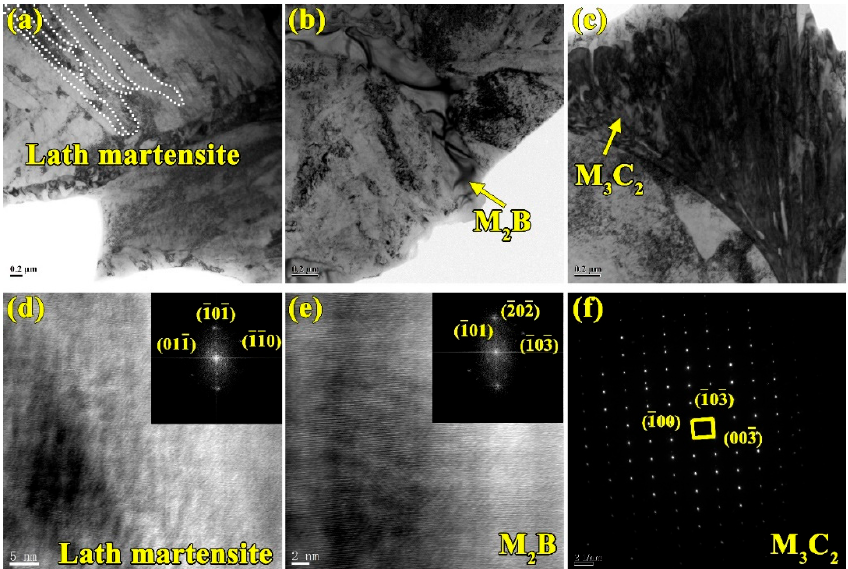
Figure 5. Transmission Electron Microscopy (TEM) of high aluminum and chromium Fe-B-C coating: ( a – c ) bright field images; ( d ) high resolution image of lath martensite and corresponding selective area diffraction (SAD) pattern; ( e ) high resolution image of M 2 B and corresponding SAD pattern; and ( f ) the SAD pattern of M 3 C 2 .